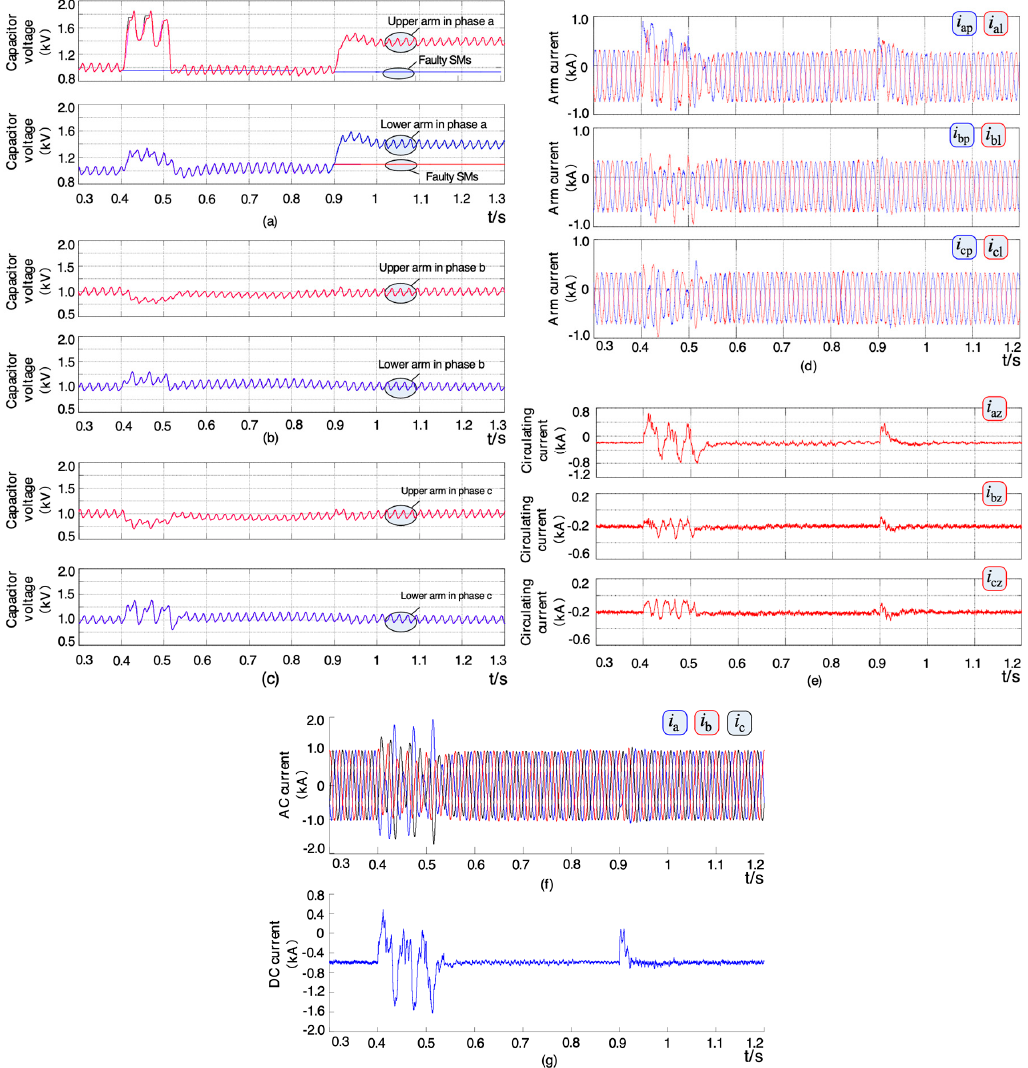
Figure 9. Simulation results of fault condition 1: ( a ) Capacitor voltage of phase a; ( b ) Capacitor voltage of phase b; ( c ) Capacitor voltage of phase c; ( d ) Arm current of phase j (j = a,b,c); ( e ) Circulating current of phase j (j = a,b,c); ( f ) AC current; ( g ) DC-link current.